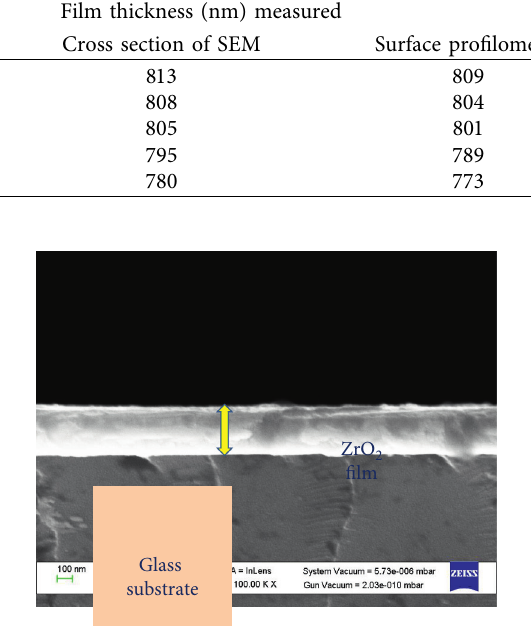
Figure 7: X-section SEM picture of ZrO